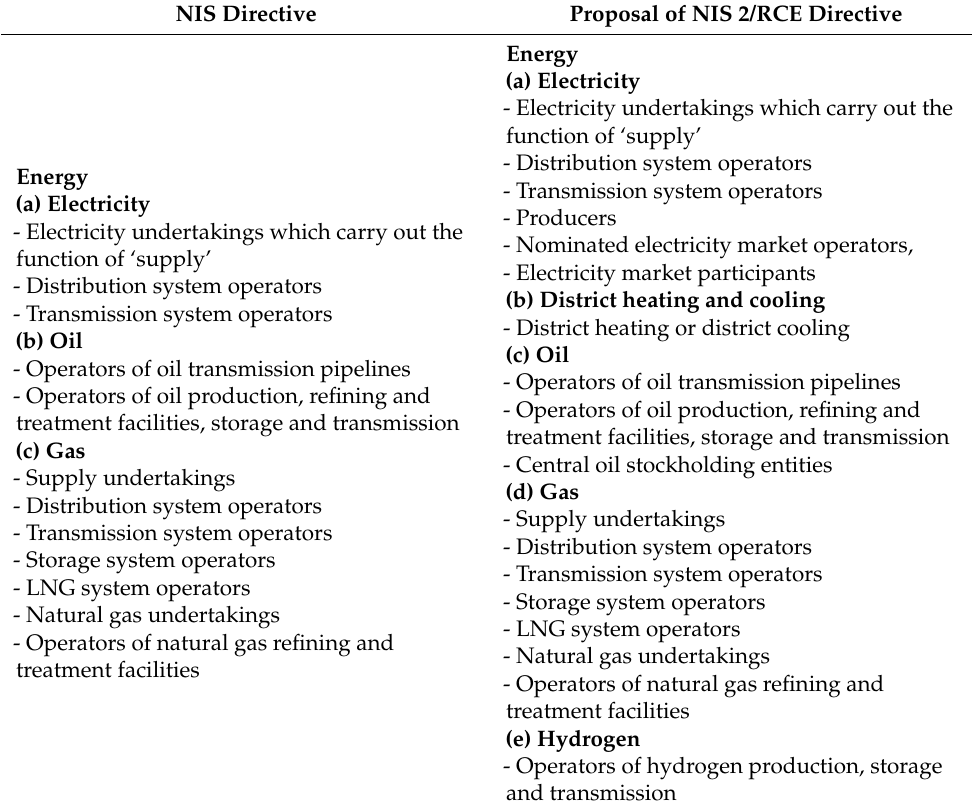
Table 1. The list of sectors, subsectors and types of entities in the NIS directive and the proposal of NIS 2/RCE